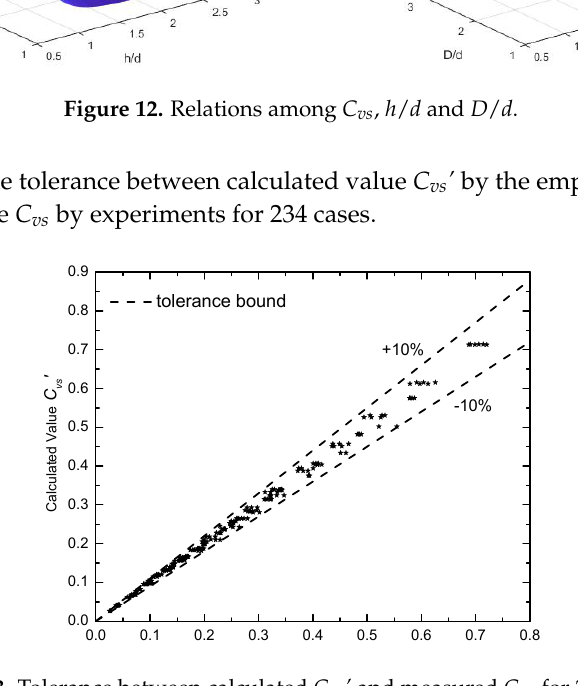
Figure 12. Relations among C vs , h / d and D / d .